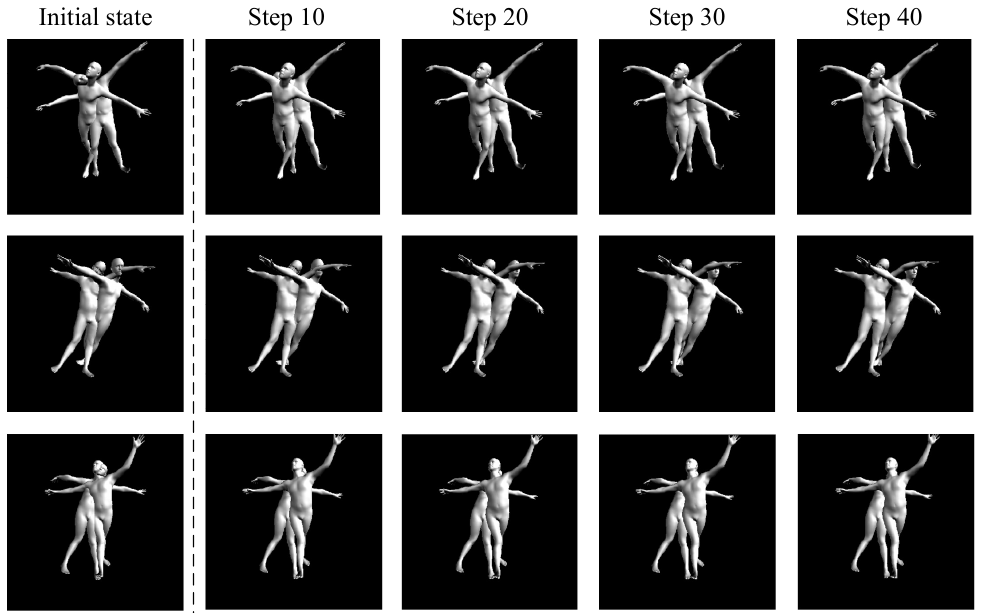
Figure 8. Images rendered from the iterative process with two SMPL models. First column: Images rendered from initial meshes with self-intersection. Second through fourth columns: Images rendered from optimized meshes every 10